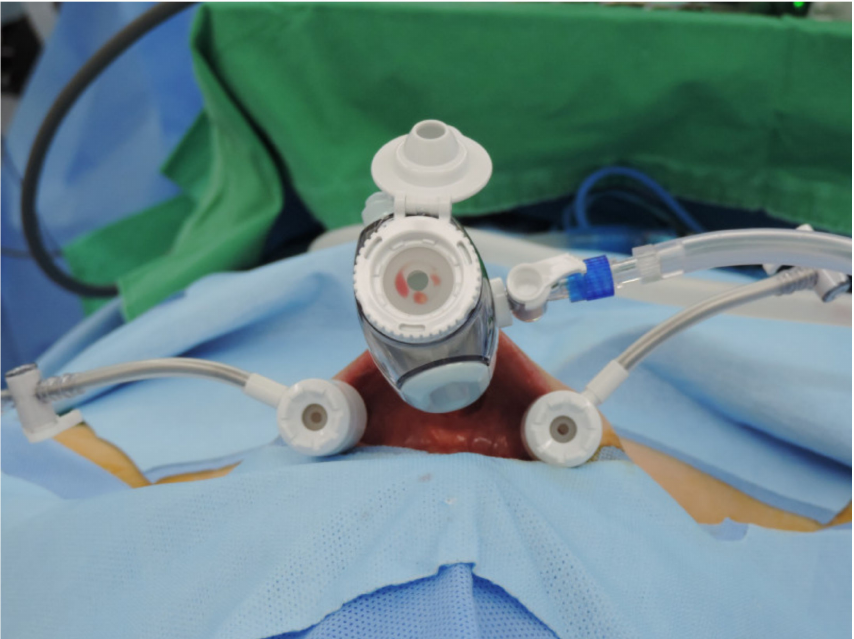
Figure 1. Trocar placement for transoral endoscopic thyroidectomy vestibular approach.